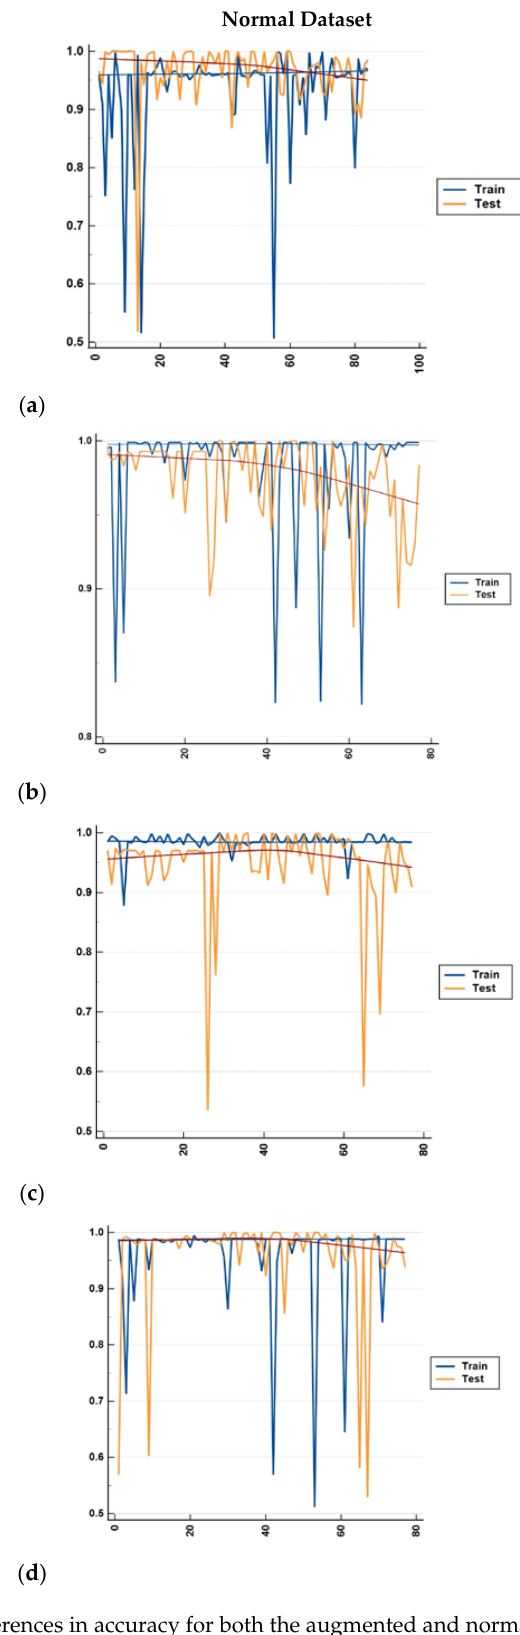
Figure 9. Comparison of the differences in accuracy for both the augmented and normal datasets for both the training data and test data. The result is shown for each fold of the 5-fold cross validation for ( a ) bagging, ( b ) random forest, ( c ) MLP, and ( d )